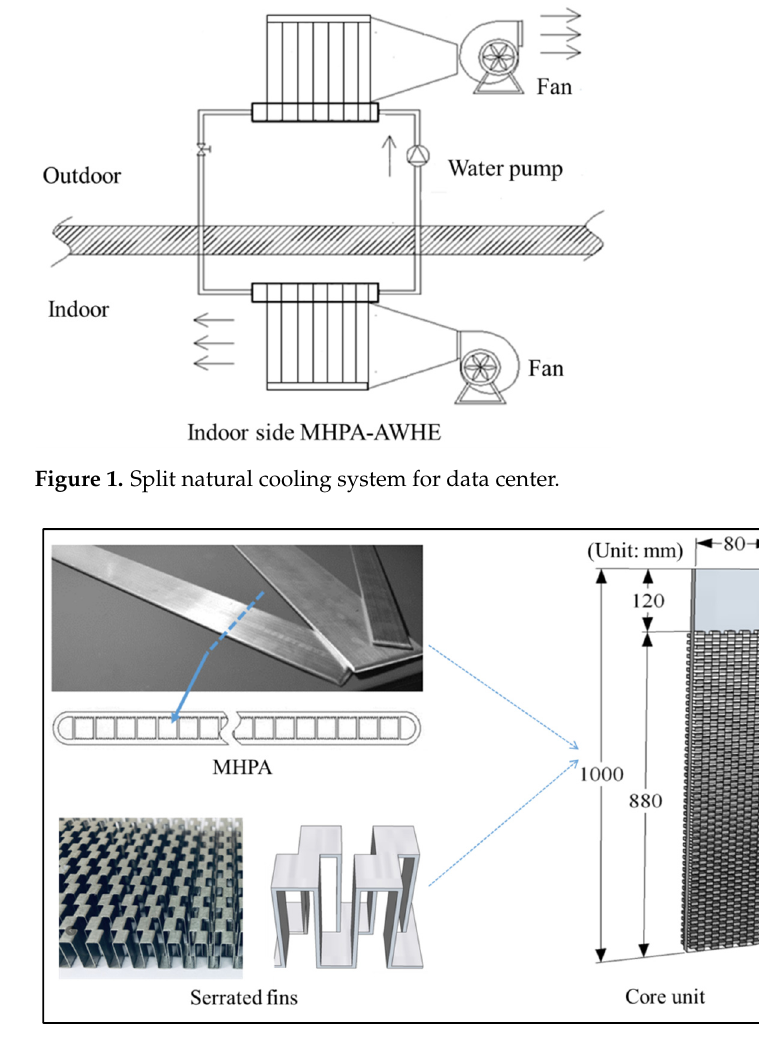
Figure 1. Split natural cooling system for data center.